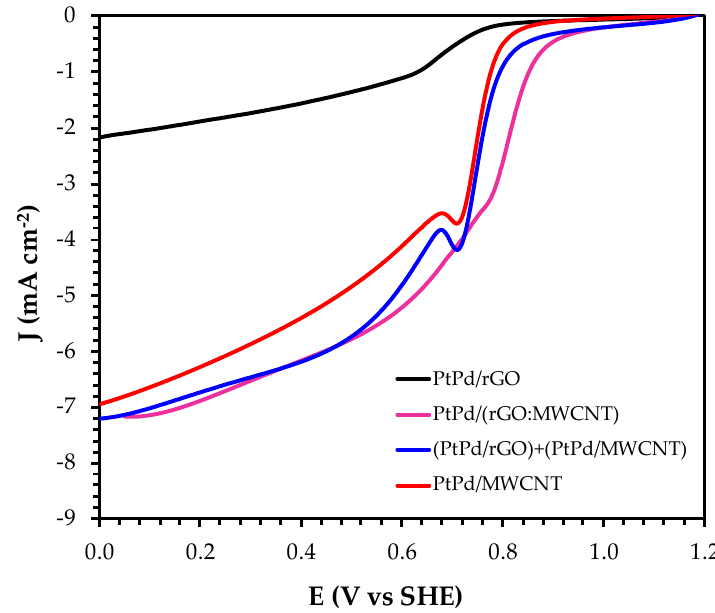
Figure 4. Comparison at 1600 rpm of linear voltammograms in O 2 -saturated H 2 SO 4 (0.5 M) at 5 mV·s − 1 for PtPd/rGO, PtPd/MWCNT, (PtPd/rGO) + (PtPd/MWCNT), and PtPd/(rGO:MWCNT).